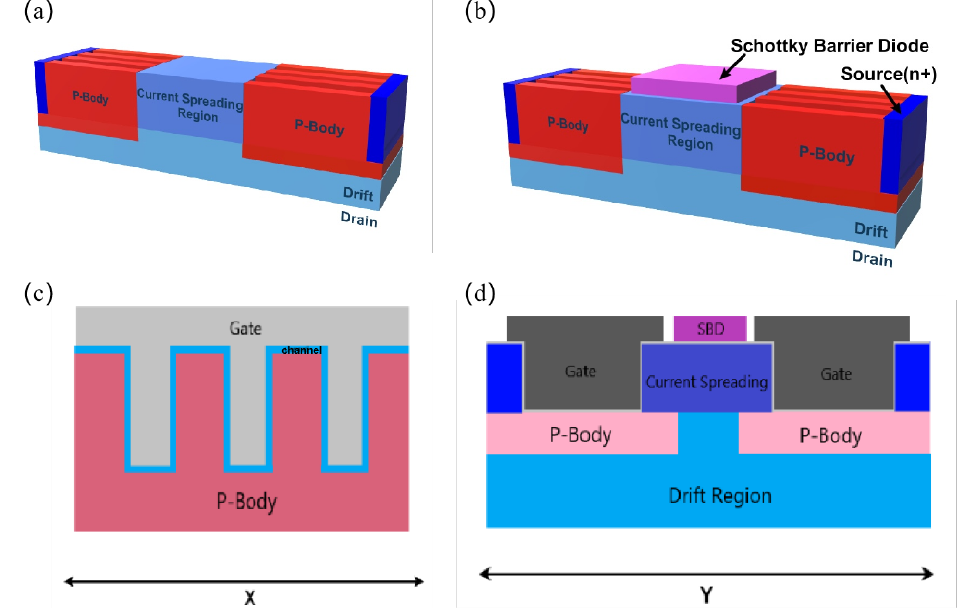
Figure 1. Schematic of ( a ) 3D view of TED MOS without SBD; ( b ) 3D view of TED MOS with SBD; ( c ) cross-sectional view of TED MOS with SBD along the x-axis; ( d ) 3D view of TED MOS with SBD along the